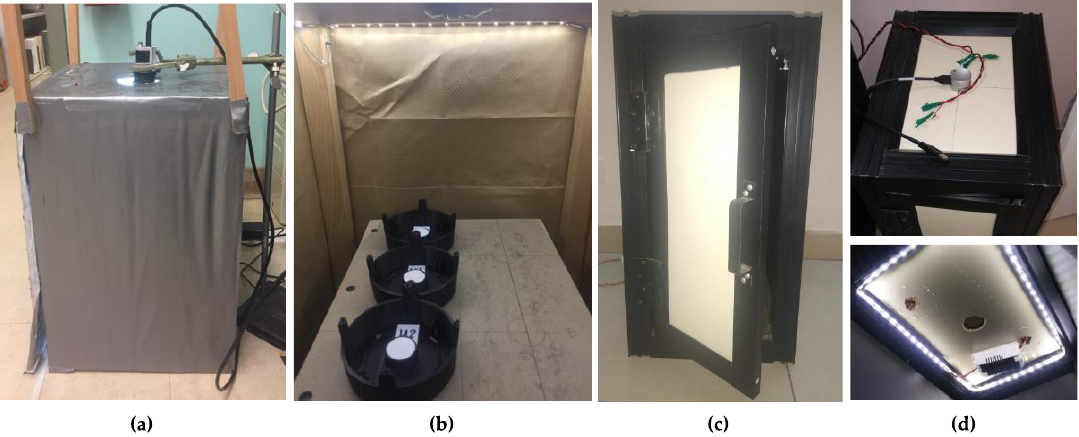
Figure A2. Lightboxes used to image exposure surfaces for the ( a–b ) preliminary laboratory testing (in Seattle, WA, USA; lightbox dimensions: 50 cm × 26 cm × 20 cm; structure materials: plywood, cardboard, paper; lighting: flexible LED strip lights (LE 4100057-DW; 24 W, 12 V), camera: digital monochrome 10-megapizel camera (Basler acA3800-14um)) and ( c–d ) preliminary field testing (in Hyderabad, India; dimensions: 60 cm × 32 cm × 17 cm; structure materials: wood; lighting: LED strip lights, camera: digital monochrome 5- megapixel camera (Basler puA2500-14um)).